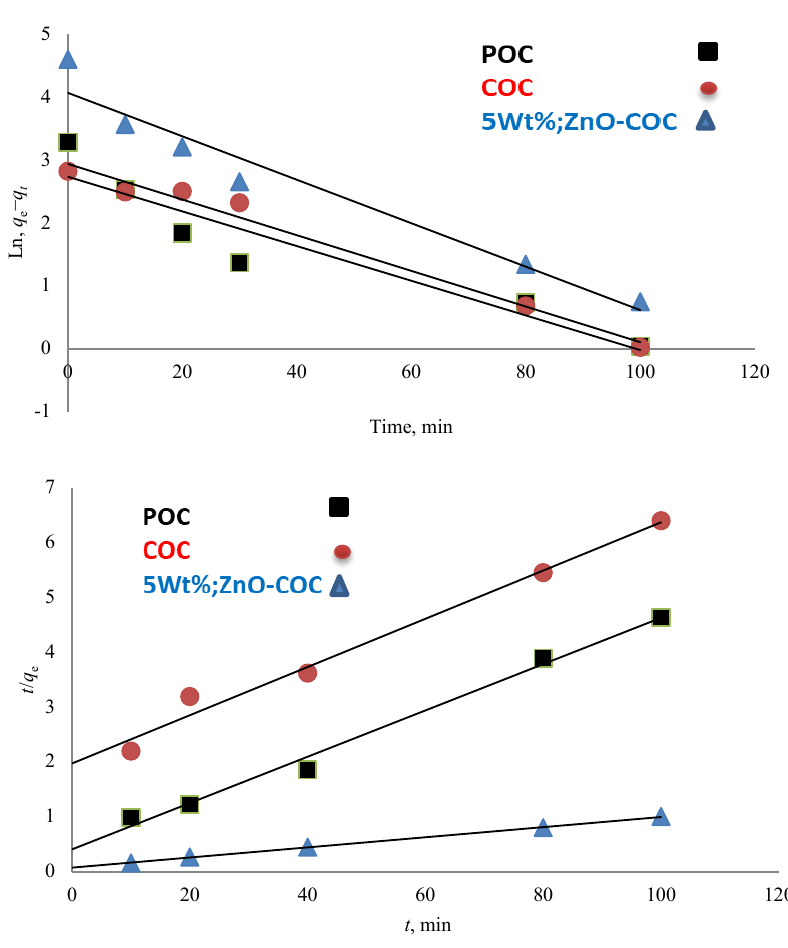
Fig. 6 . Linear regressions of MB adsorption kinetics of (A) pseudo first order and (B) pseudo second order of (■) purified clay ( ● ) calcined clay and ( ▲ ) impregnated clay (pH = 6.8; m = 0.025 g; V = 50 mL; Ci = 50 mg L –1 ; T = 24